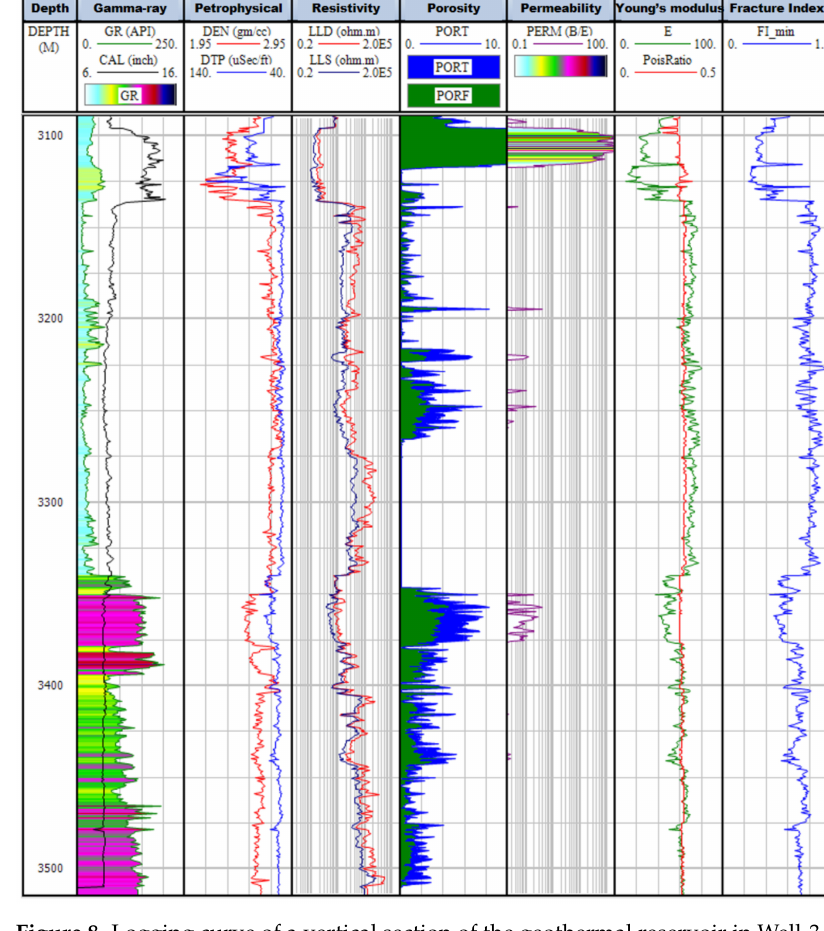
Figure 8. Logging curve of a vertical section of the geothermal reservoir in Well-3.